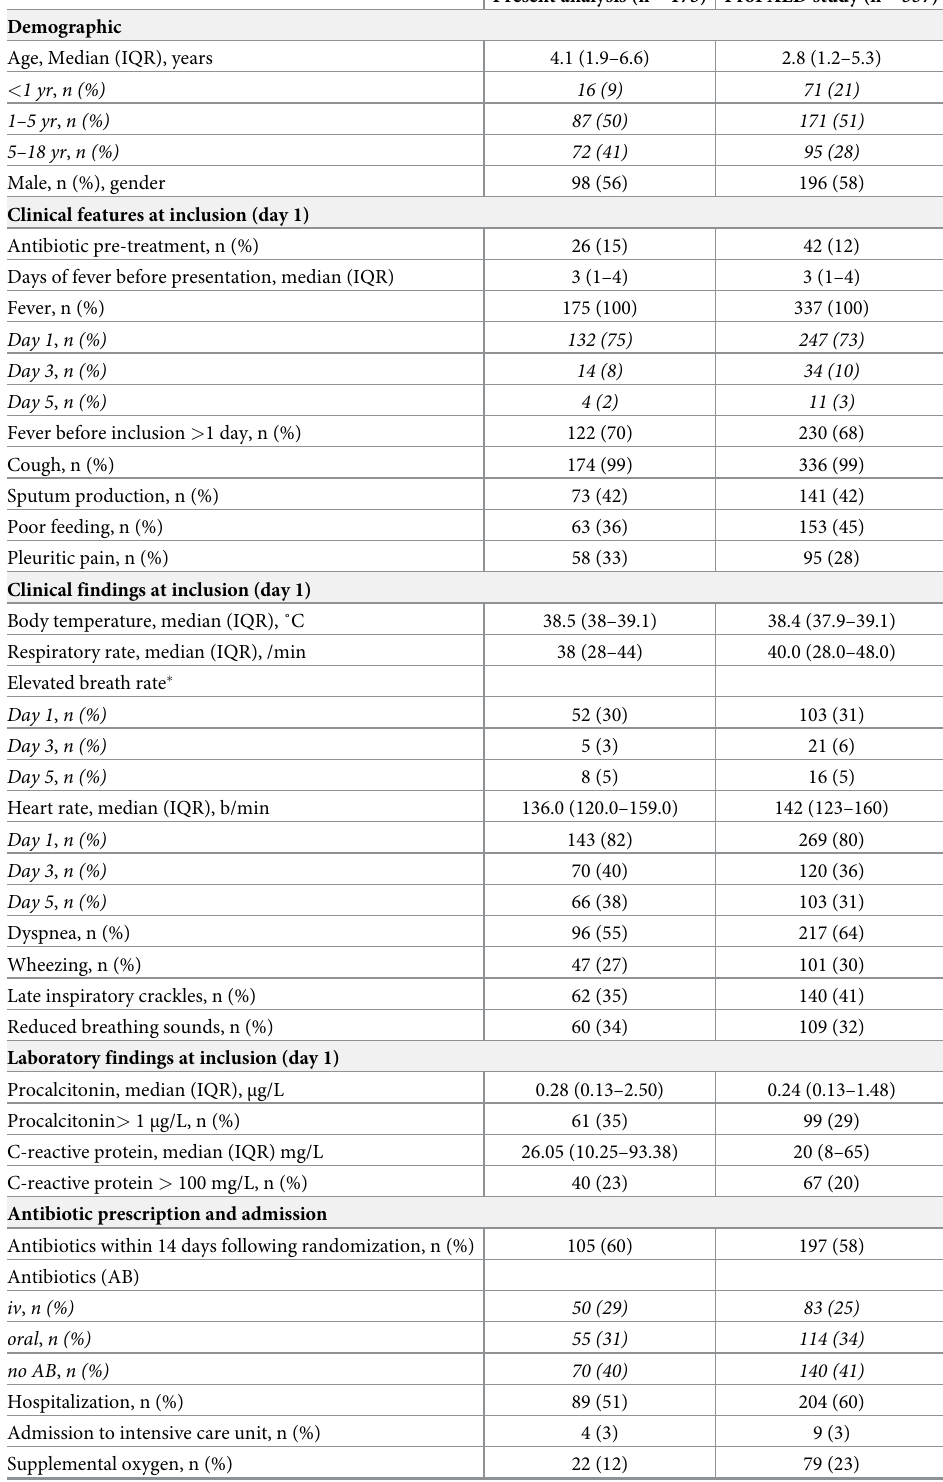
Table 1. Characteristics of the population included for present analyses and the ProPAED study